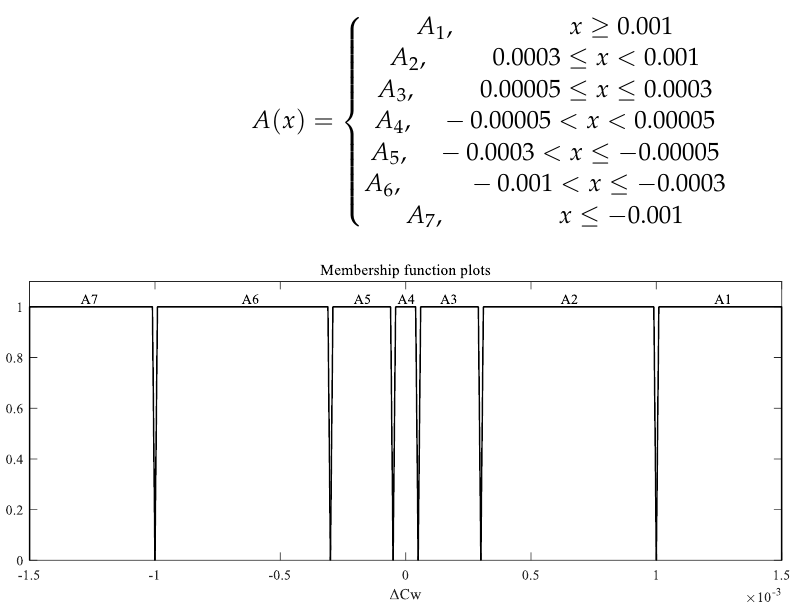
6 of 14 Table 1. Trim rules corresponding to loads change in helicopter wind tunnel test. (In the table, ↑↑ represents more increment, ↑ represents less increment, ↓↓ represents more decrease, ↓ represents less decrease, and ○ represents basically unchanged.) θ col